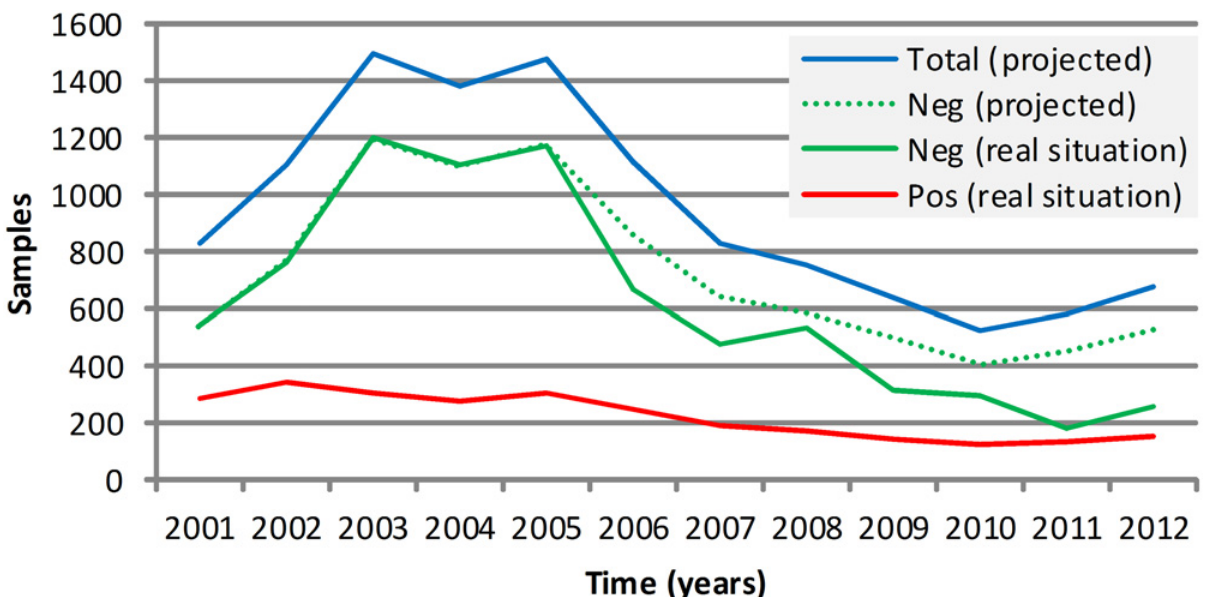
Fig 8. Projected epidemiological scenario of animal rabies in Minas Gerais, Brazil, from 2006 to 2012 estimated from the positivity rate of the first study period (2001 to 2005).